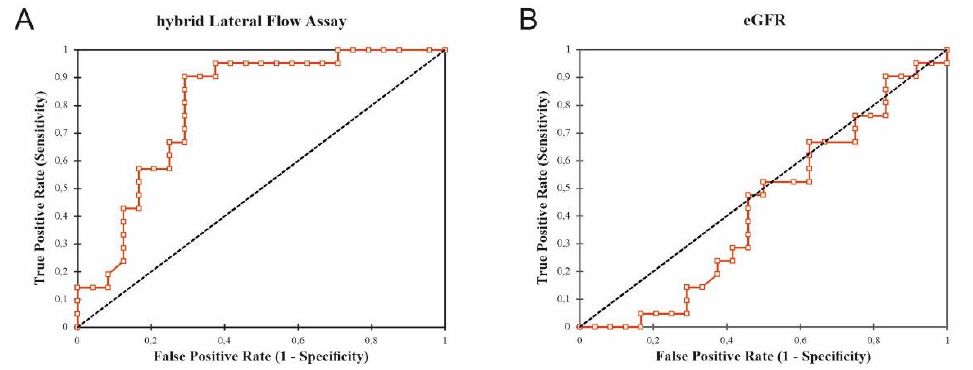
Figure 8. Area under the curve (AUC) values in receiver operating characteristic (ROC) analyses of ( A ) hybrid-LFA (AUC = 0.799) and ( B ) estimated glomerular filtration rate (eGFR, AUC = 0.428) at day of biopsy.